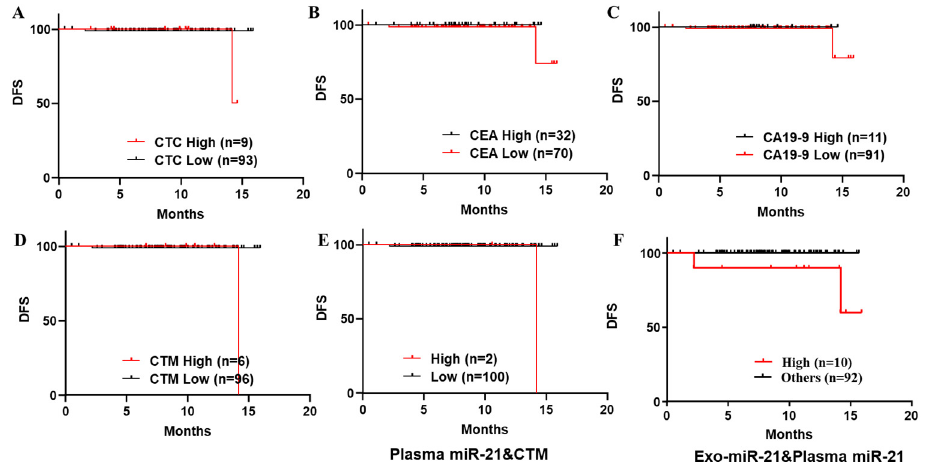
Figure 5. Kaplan–Meier survival analyses on DFS curves to differentiate recurrence in patients with stage I to III CRC by individual and combined biomarkers. ( A – D ) DFS curve to differentiate recurrence in patients with stage I to III CRC stratified by numbers of CTC ( A ), serum CEA level ( B ), CA19-9 ( C ) and presence of CTM ( D ), individually. ( E ) DFS curve to differentiate recurrence in patients with stage I to III CRC stratified by considering the combination of plasma miR-21 and CTM. ( F ) DFS curve to differentiate recurrence in patients with stage I to III CRC stratified by considering the combination of plasma and exosomal miR-21.